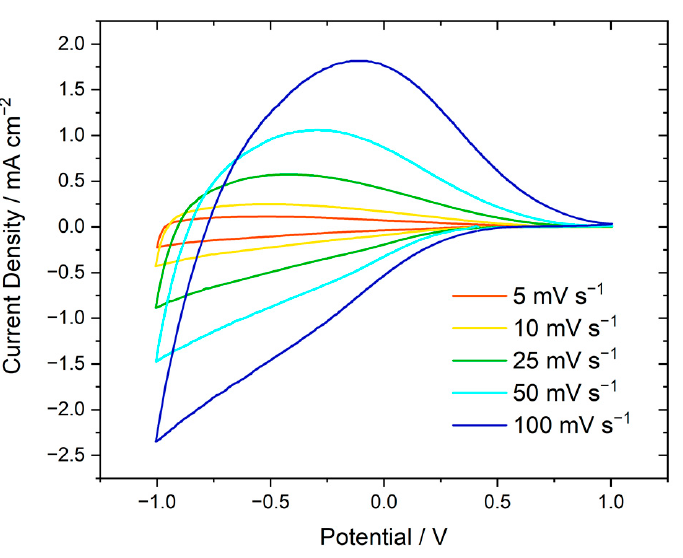
Figure 5. Cyclic voltammograms at the second cycle at different scan rates of a WO 3| µ mp film in LiClO 4 in PC.